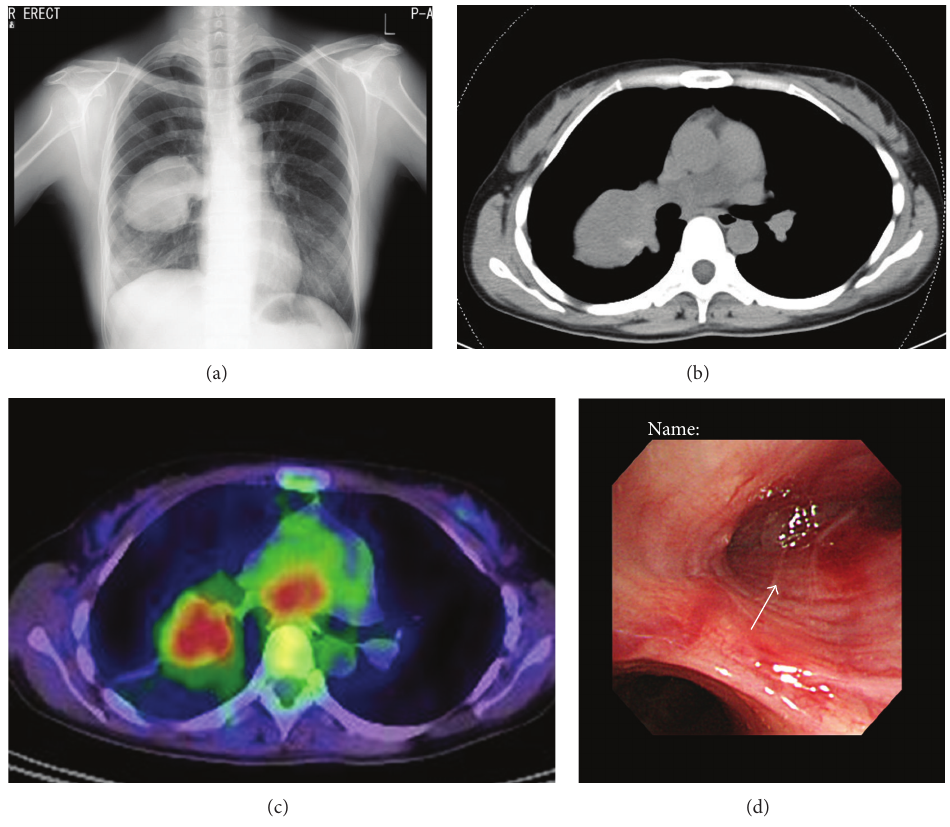
Figure 1: (a) Chest radiography showing a mass in the right middle lung field. (b) Noncontrast CT showing a mass approximately 8 centimeters in diameter with relatively smooth margins in the right lung segment 6. (c) Fluorodeoxyglucose-positron emission tomography showing accumulation in the right lung mass and in the lesion in the mediastinum. (d) On bronchoscopy, a whitish tumorous lesion was seen obstructing right B6 (arrow).